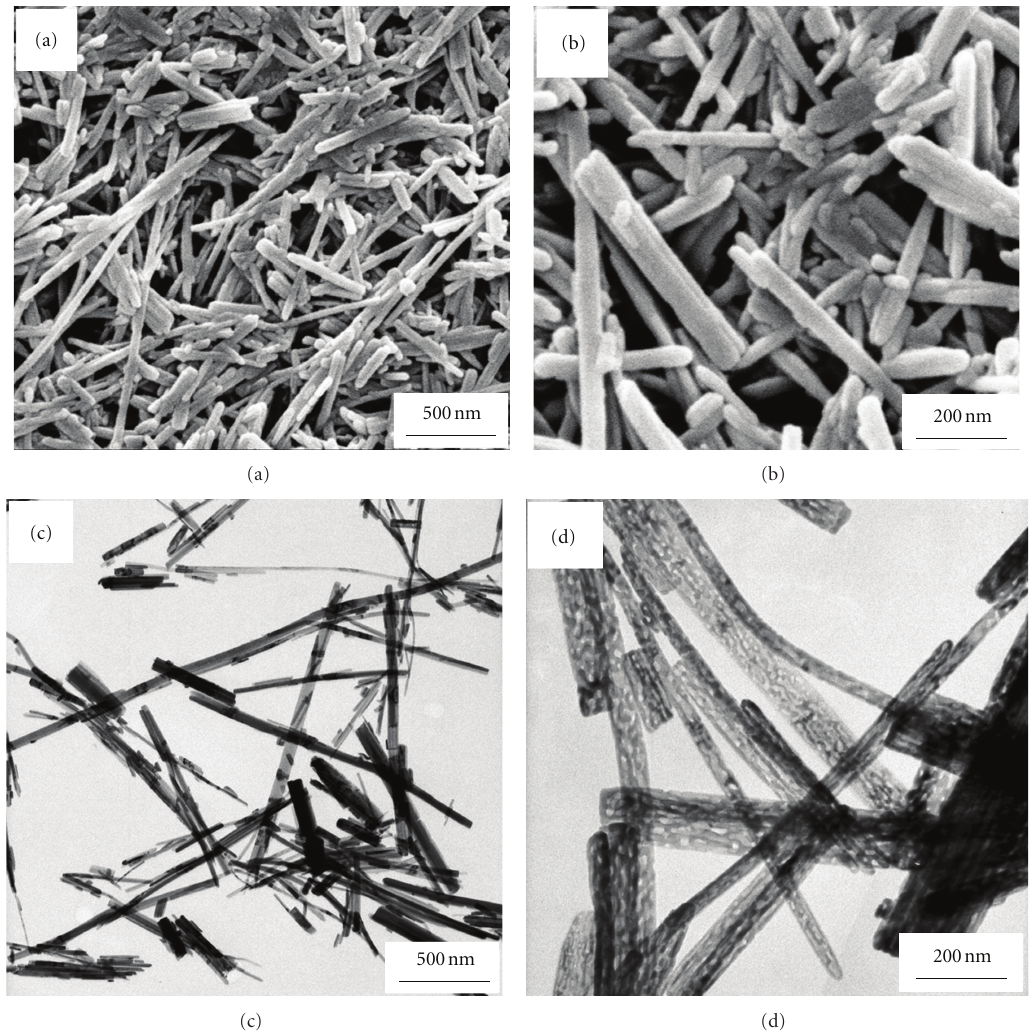
Figure 3: SEM (a, b) and TEM (c, d) images of the mesoporous BiVO 4 nanorods with di ff erent